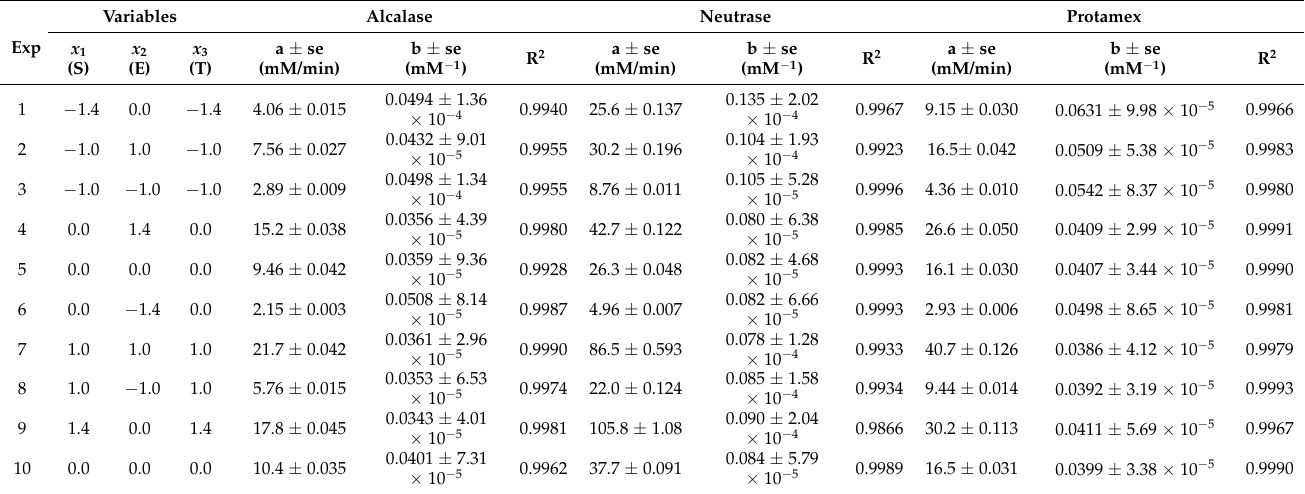
Table 2. Experimental CCC design and kinetic constant values obtained from fitting to hydrolysis curves and %DH after 60 min of